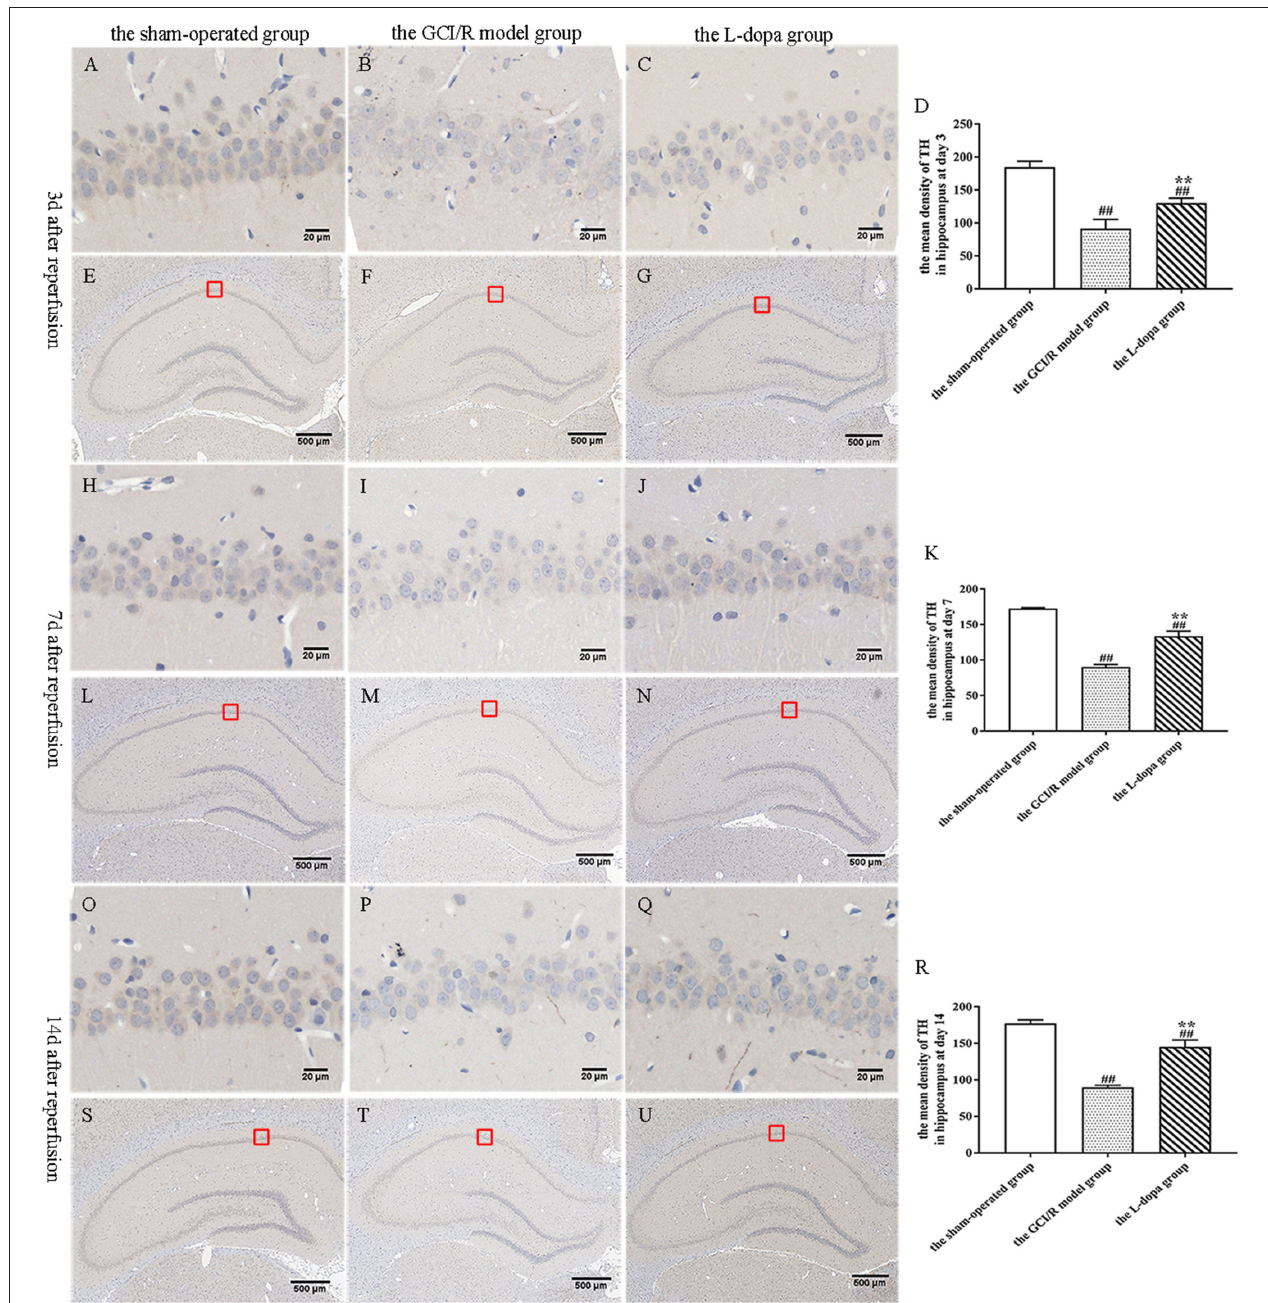
FIGURE 6 | TH immunohistochemical staining of hippocampus. (A–U) Representative section for TH immunohistochemical staining at 3, 7, and 14 days after GCI/R injury. Scale bar 500 µ m for Magnification 4 × , Scale bar 20 µ m for Magnification 20 × . (D) The mean density of TH in hippocampus at 3 day after GCI/R injury. (K) The mean density of TH in hippocampus at day 7 after GCI/R injury. (R) The mean density of TH in hippocampus at day 14 after GCI/R injury. Data are shown as means ± SD. ## p < 0.01 vs. the sham-operated group, ** p < 0.01 vs. the GCI/R model group.